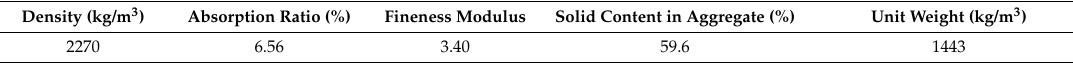
Table 3. The physical properties of recycled fine aggregate.